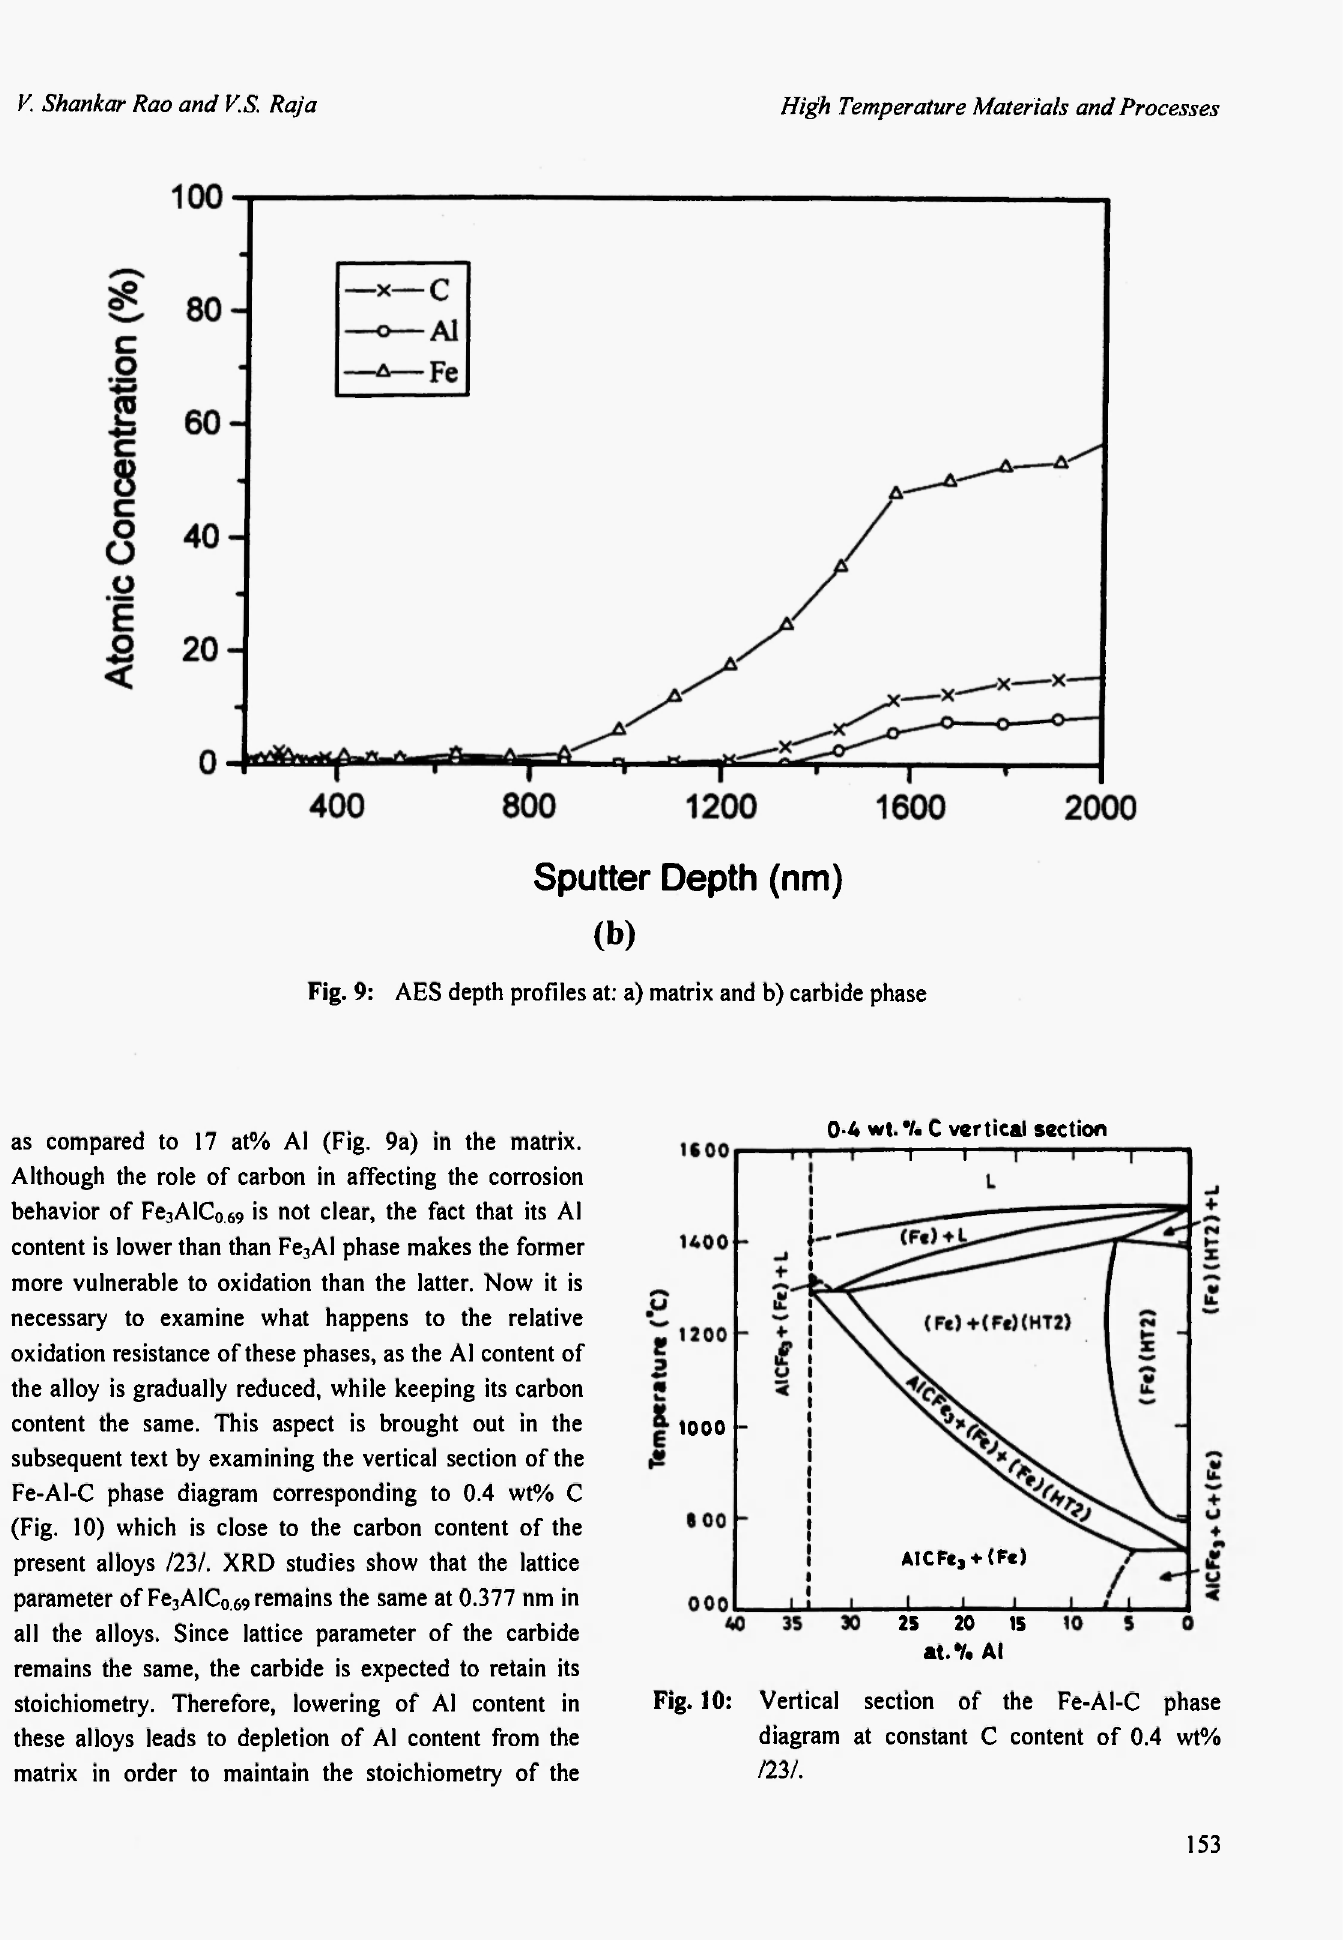
Fig. 10: Vertical section of the Fe-AI-C phase diagram at constant C content of 0.4 wt%